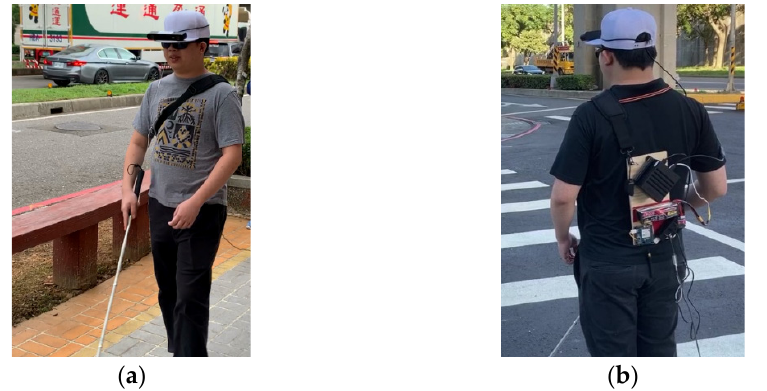
Figure 12. The visually impaired person was experimenting, ( a ) the front view; ( b ) the back view.